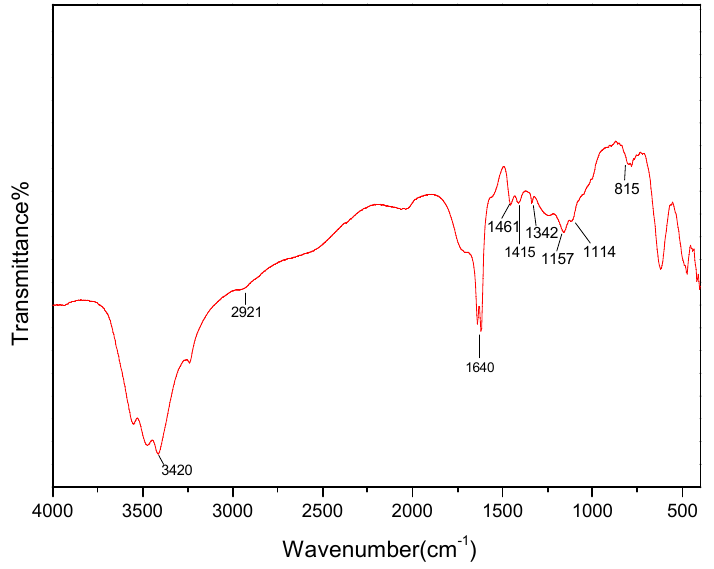
Figure 4. FT-IR spectrum of the prepared straw-biopolymer-based hydrogel.